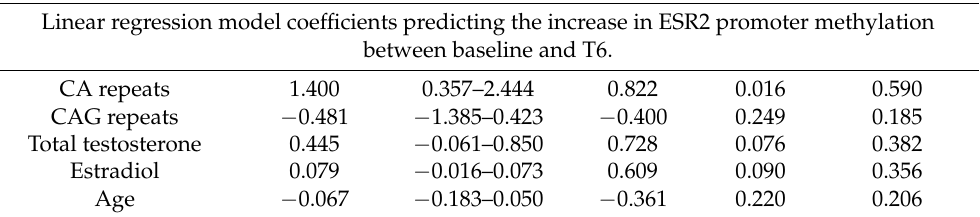
Linear regression model coefficients predicting the increase in ESR2 promoter methylation between baseline and T12. B CI 95% Beta p CA repeats 0.498 − 0.270–1.266 Total testosterone